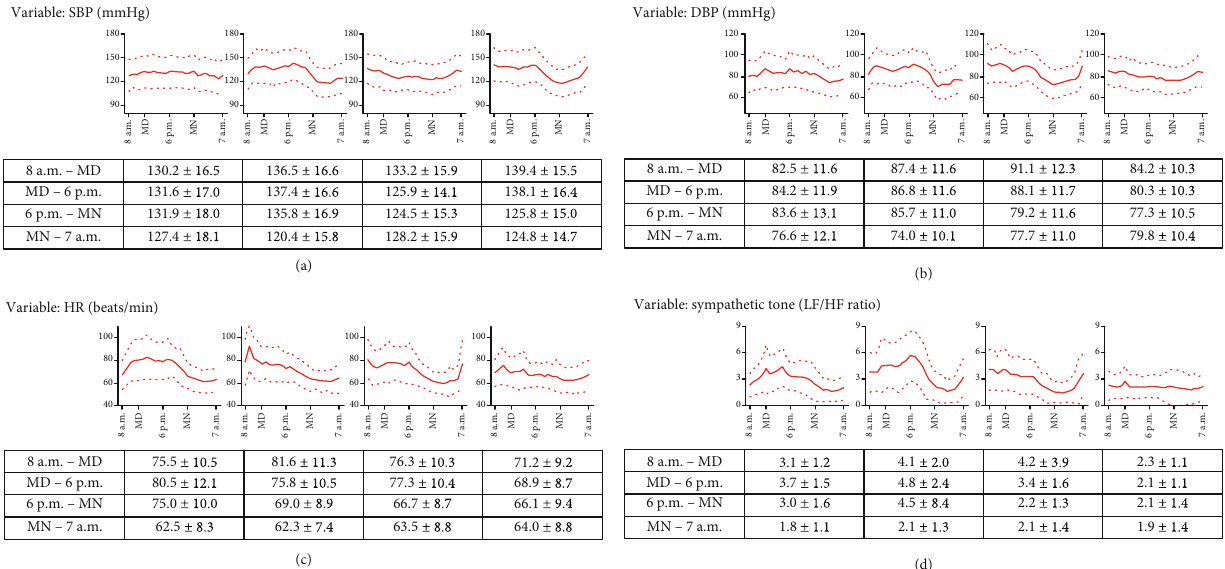
Figure 2: Time series patterns of the SBP, DBP, HR, and sympathetic tone clusters. In each cluster, the time series measurements are visualized as a graph showing mean values (red line) and mean ± 2 standard deviation values (red dotted lines) of the measurements. Data are expressed as mean ± standard deviation . SBP: systolic blood pressure; DBP: diastolic blood pressure; HR: heart rate; LF: low